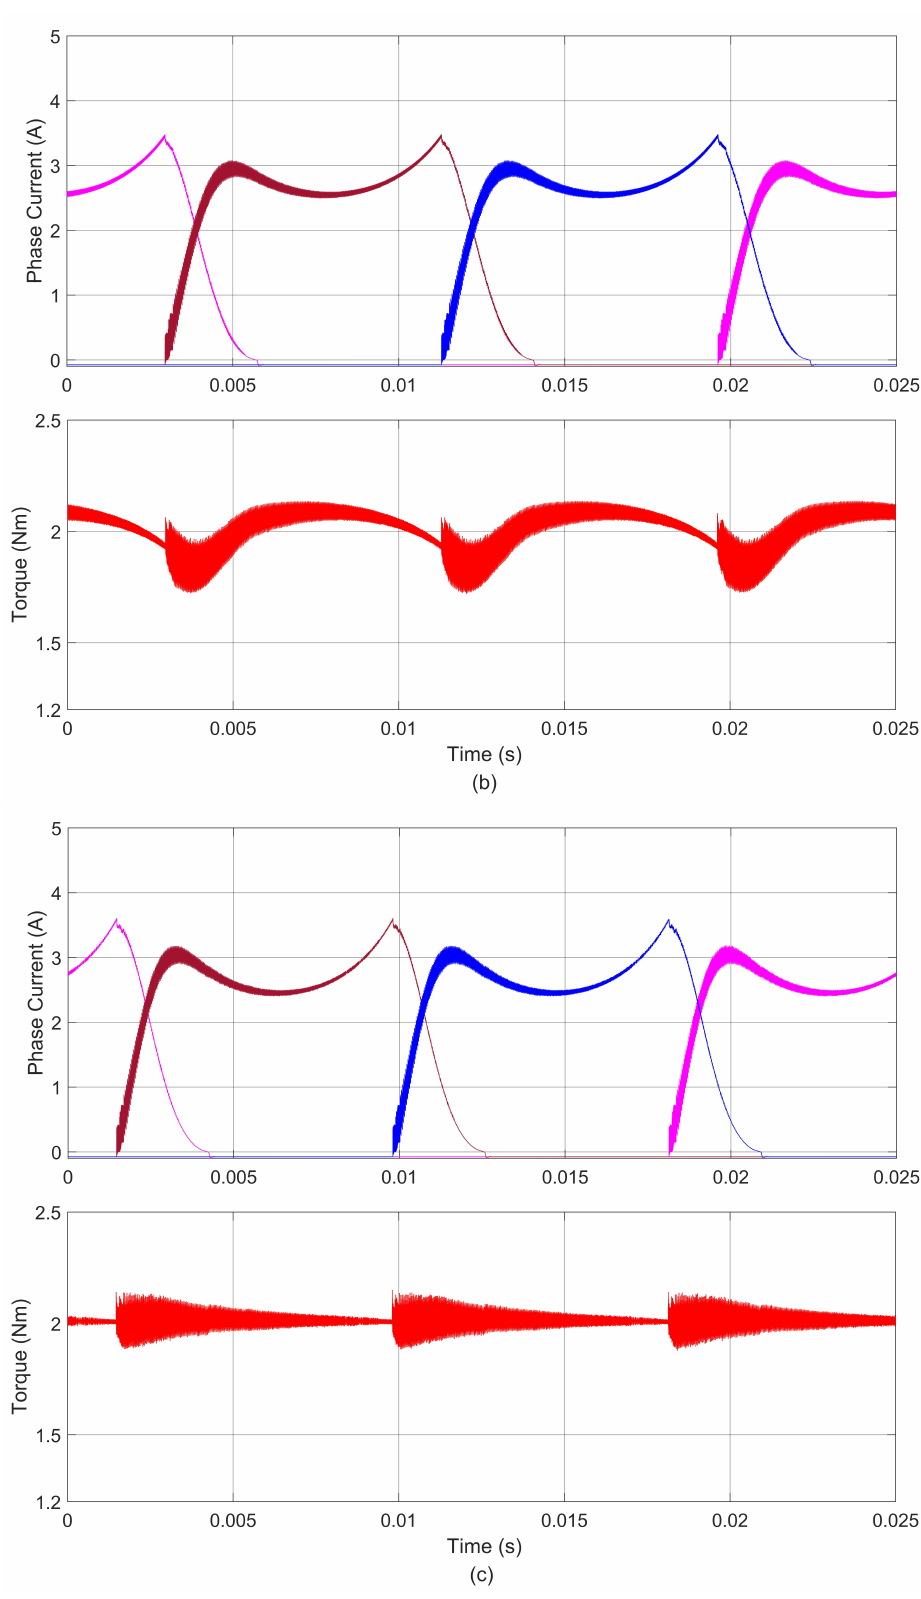
Figure 10. Phase current and electromagnetic torque at 2 Nm, 300 rpm with ( a ) fuzzy compensator, ( b ) PD compensator, and ( c )